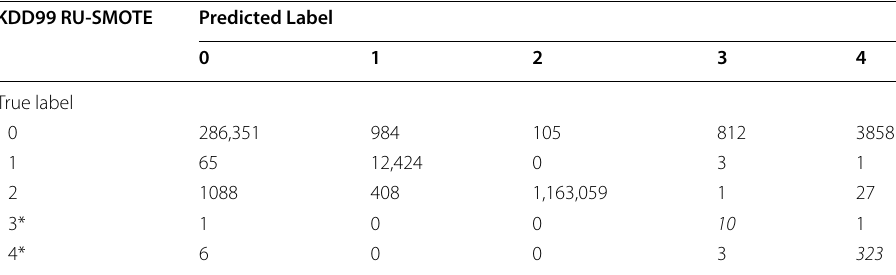
Table 17 Confusion Matrix: KDD99 RU-SMOTE KDD99 RU‑SMOTE